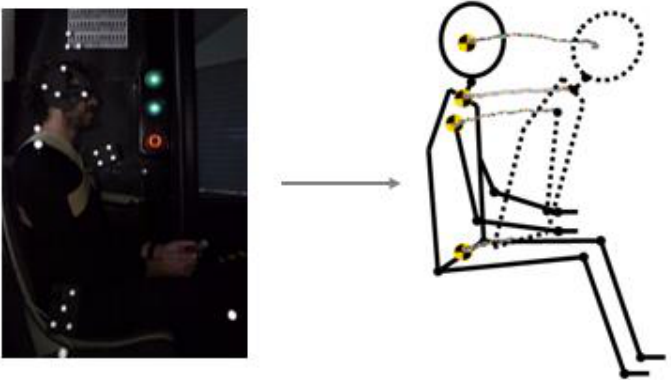
Figure 10. The trajectory of position markers of a volunteer during BT1.